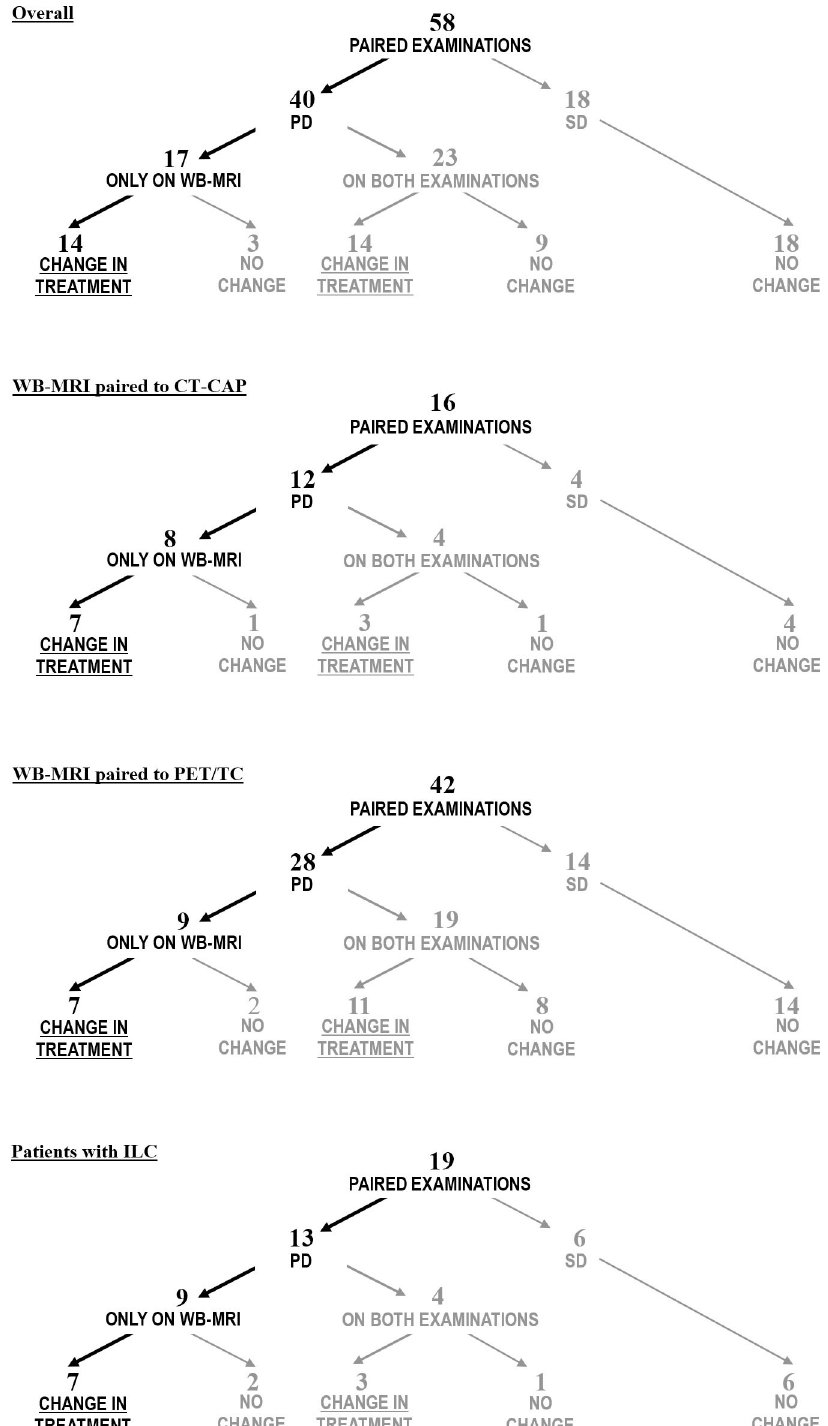
Fig 1. Impact on treatment: Overall and subgroup analyses. The flowcharts in this picture illustrate how often the imaging outcomes motivated changes of treatment in our cohort, with a distinction between the cases of PD reported only on WB-MRI and those in which PD was reported on both examinations (WB-MRI and the control examination). The first flowchart includes all 58 paired examinations (overall analysis). Separate analyses are shown for specific subgroups in the following flowcharts, including analyses of all 16 paired examinations in which WB-MRI was paired